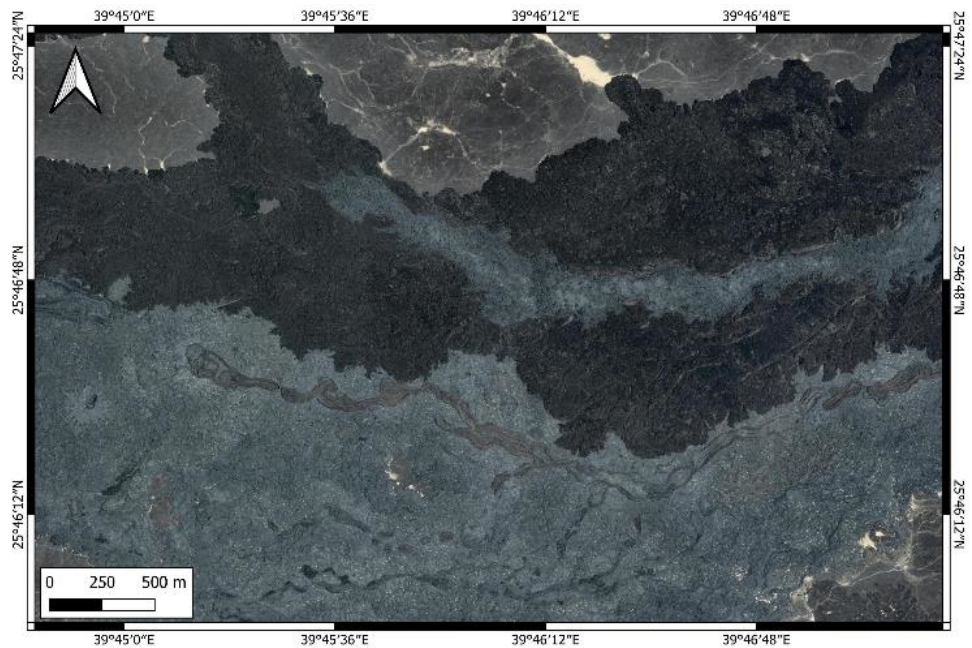
Figure 13. Complex lava flow path in medial section of one of the youngest lava flows. Note the complex rubble and shiny, shelly p¯ahoehoe surfaces as well as the narrow, thin-crusted flow channels, all indicating a dynamic lava flow emplacement environment where ponding, inflation, deflation, and localized and general surface crust breach generate a complex lava flow surface texture.